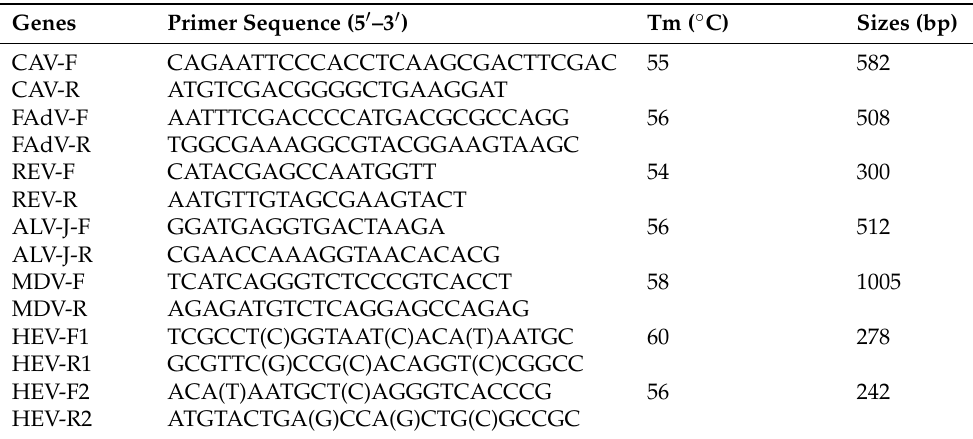
Table 1. Primer sequences used in the study.